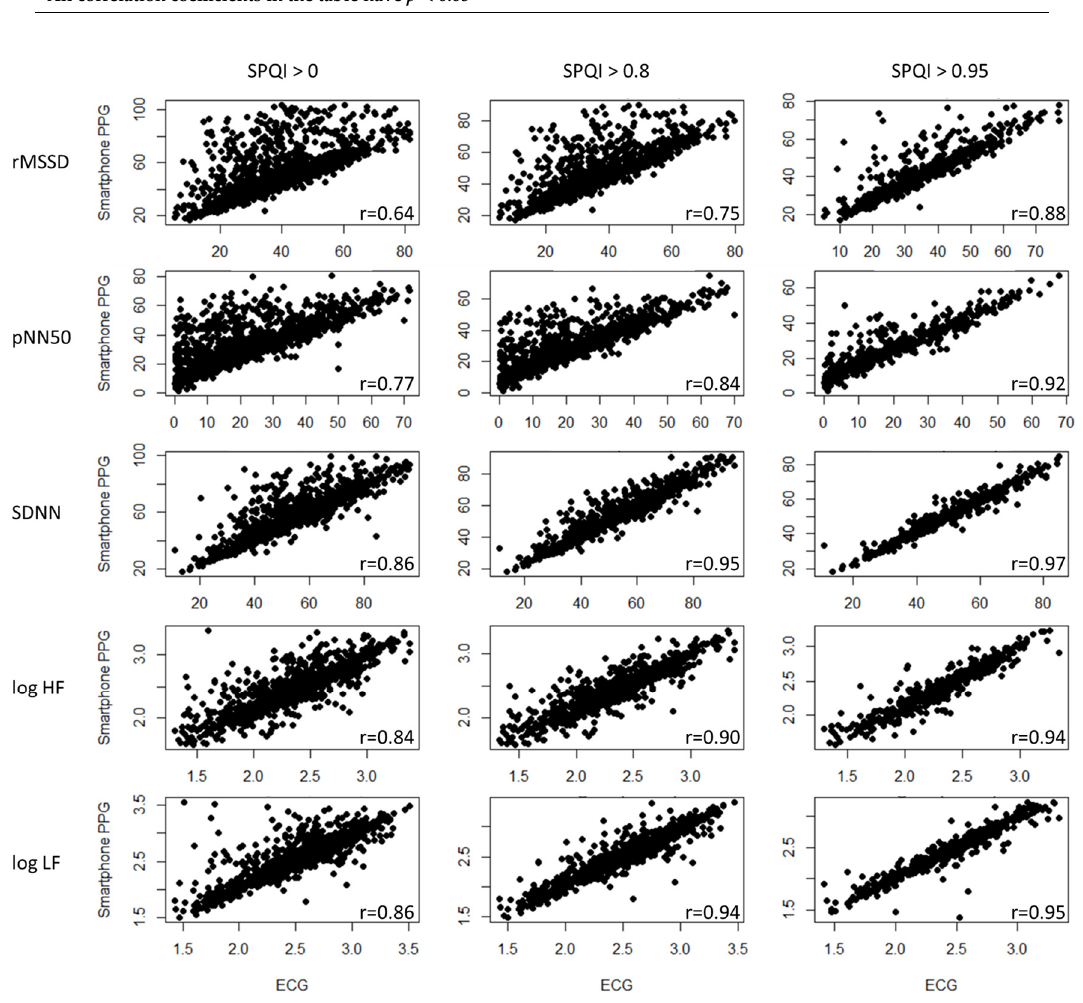
Table 4. Number of valid samples filtered by different smartphone PPG quality index (SPQI) levels. Threshold